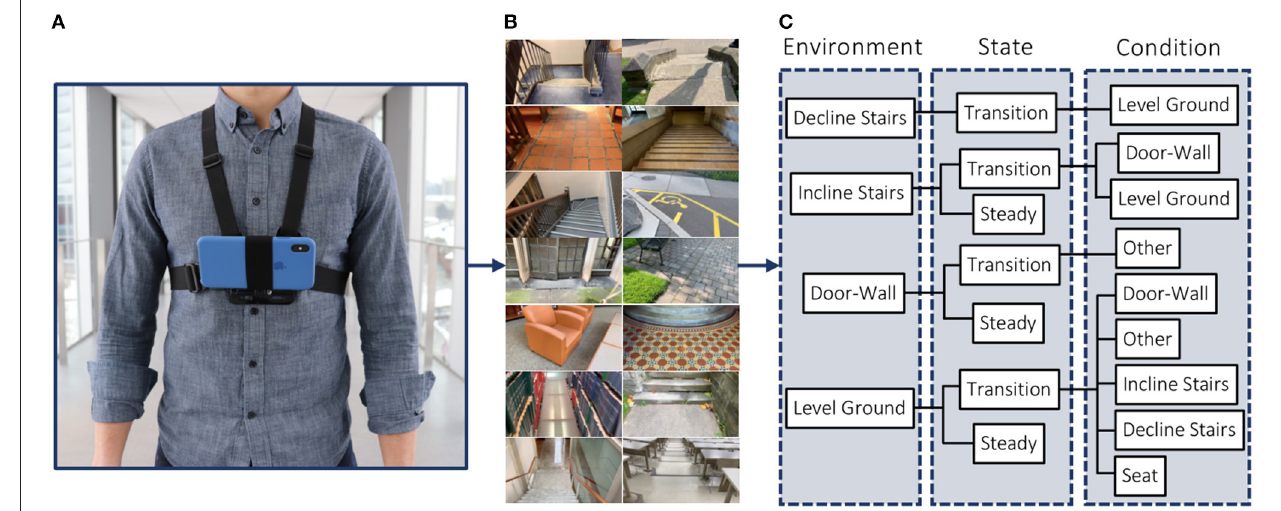
FIGURE 4 | Development of the “ExoNet” database, including (A) a photograph of the wearable camera system used for large-scale data collection; (B) examples of the high-resolution RGB images of walking environments; and (C) a schematic of the 12-class hierarchical labeling architecture.